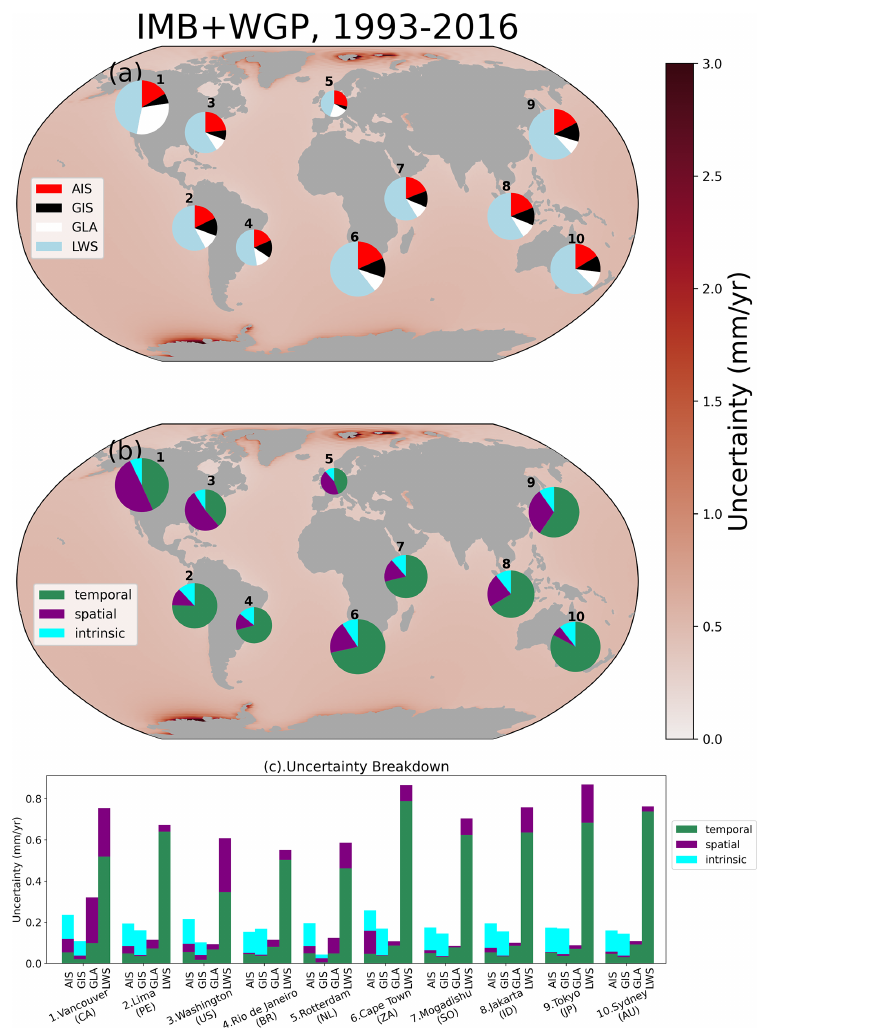
Figure 8. Pie charts represent the total uncertainty separated by (a) contribution and (b) type of uncertainty, and the bars show the breakdown for each contribution (c) . Background maps show the total GRD-induced uncertainty. The size of the pie charts is relative to the magnitude of the total uncertainty. Note that the uncertainties are combined in quadrature, so simply adding up the bars in panel (c) will not reflect the size of the pie charts in panels (a) and (b)